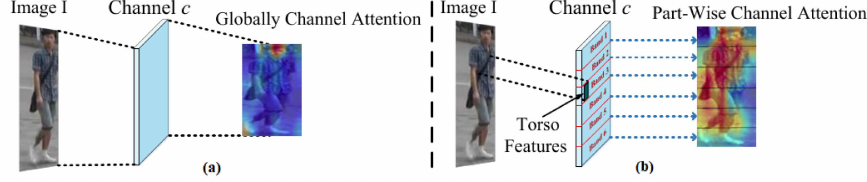
Figure 5. ( a ) Global channel attention [44,45]. ( b ) Our part-wise channel